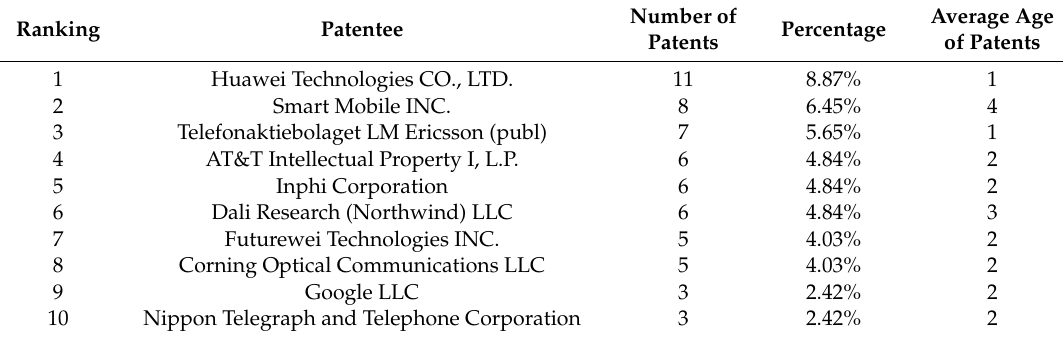
Table 3. Number of approved patents of the top 10 patentees.